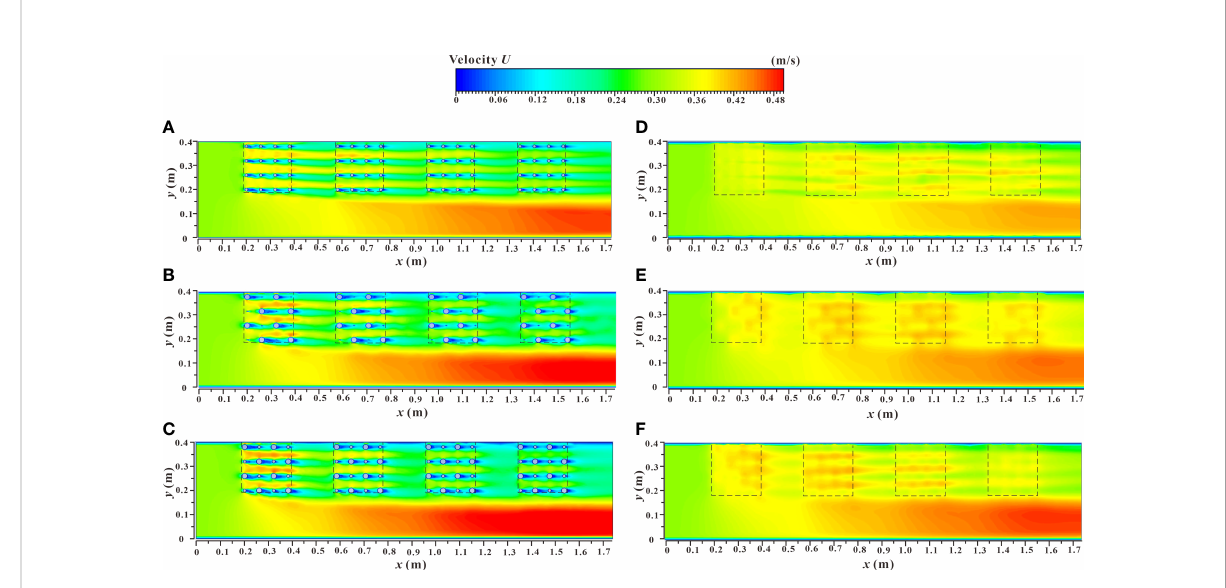
FIGURE 9 Spatial distribution of velocity contours of xy sections under different submerged states. (A) h = 0.06 m, d & D = 0.012 m & 0.012 m, non- submerged vegetation, (B) h = 0.06 m, d & D = 0.003 m & 0.021 m, non-submerged vegetation, (C) h = 0.06 m, d & D = 0.012 m & 0.021 m, non-submerged vegetation, (D) h = 0.10 m, d & D = 0.012 m & 0.012 m, submerged vegetation, (E) h = 0.10 m, d & D = 0.003 m & 0.021 m, submerged vegetation, (F) h = 0.10 m, d & D = 0.012 m & 0.021 m, submerged